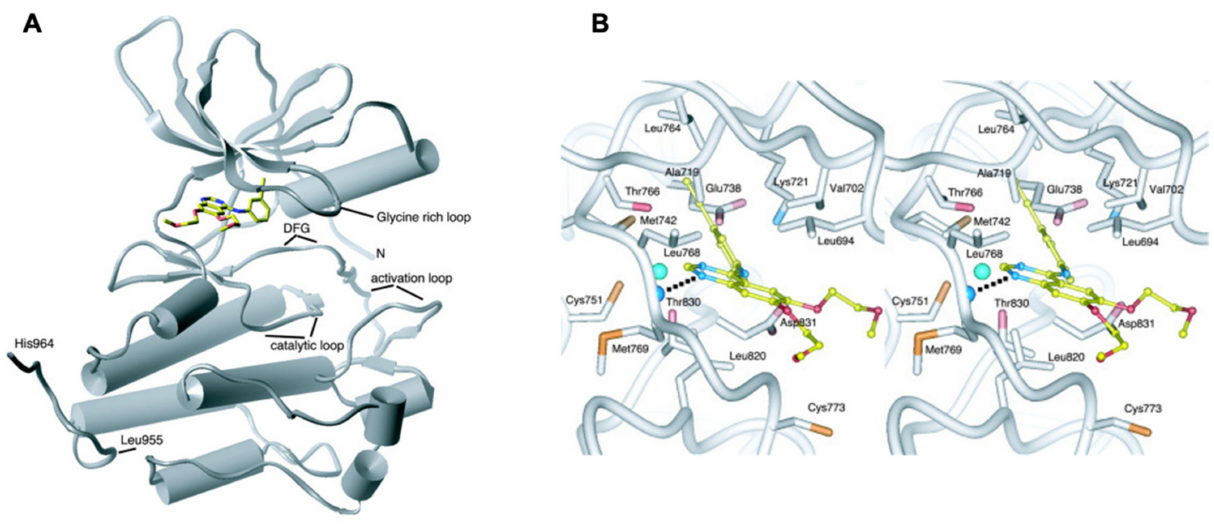
Figure 6. EGFR-erlotinib binding structure: Erlotinib binds at the gap between the EGFR kinase domain’s amino- and carboxy-terminal lobes (PDB: 1M14). ( A , B ) A stereo image of the inhibitor binding site and surrounding EGFRK/erlotinib residues. An H-bond from the Met769 amide nitrogen to erlotinib is indicated by a dashed line (It was procured from Stamos et al.